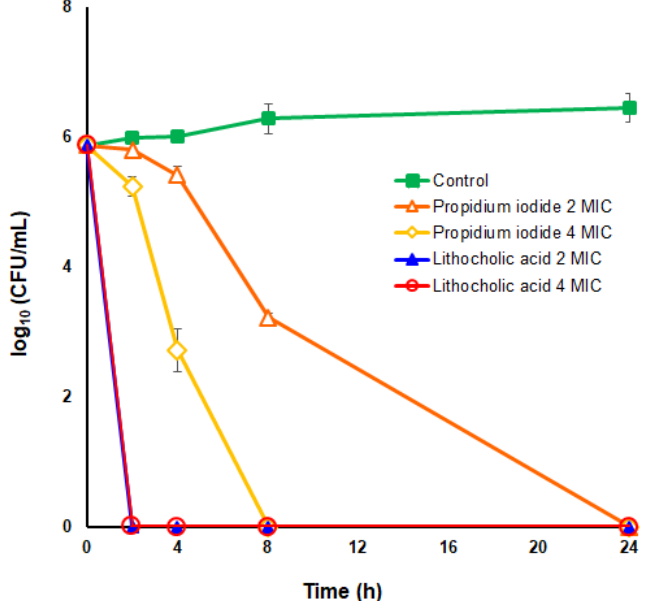
Figure 3. Time-kill kinetics of propidium iodide and lithocholic acid against H. pylori strain ATCC 700684. Bacterial counts were determined at time zero and after 2, 4, 8, and 24 hours of incubation with 2 × MIC and 4 × MIC of each drug. Mixtures of bacteria with DMSO (vehicle) instead of the drug were used as controls. Values are the averages of three independent determinations; vertical bars represent standard deviations. Please note that in some instances the error is smaller than the symbols used.